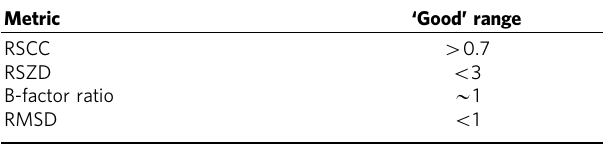
Table 2 | Acceptable values of ligand validation scores.